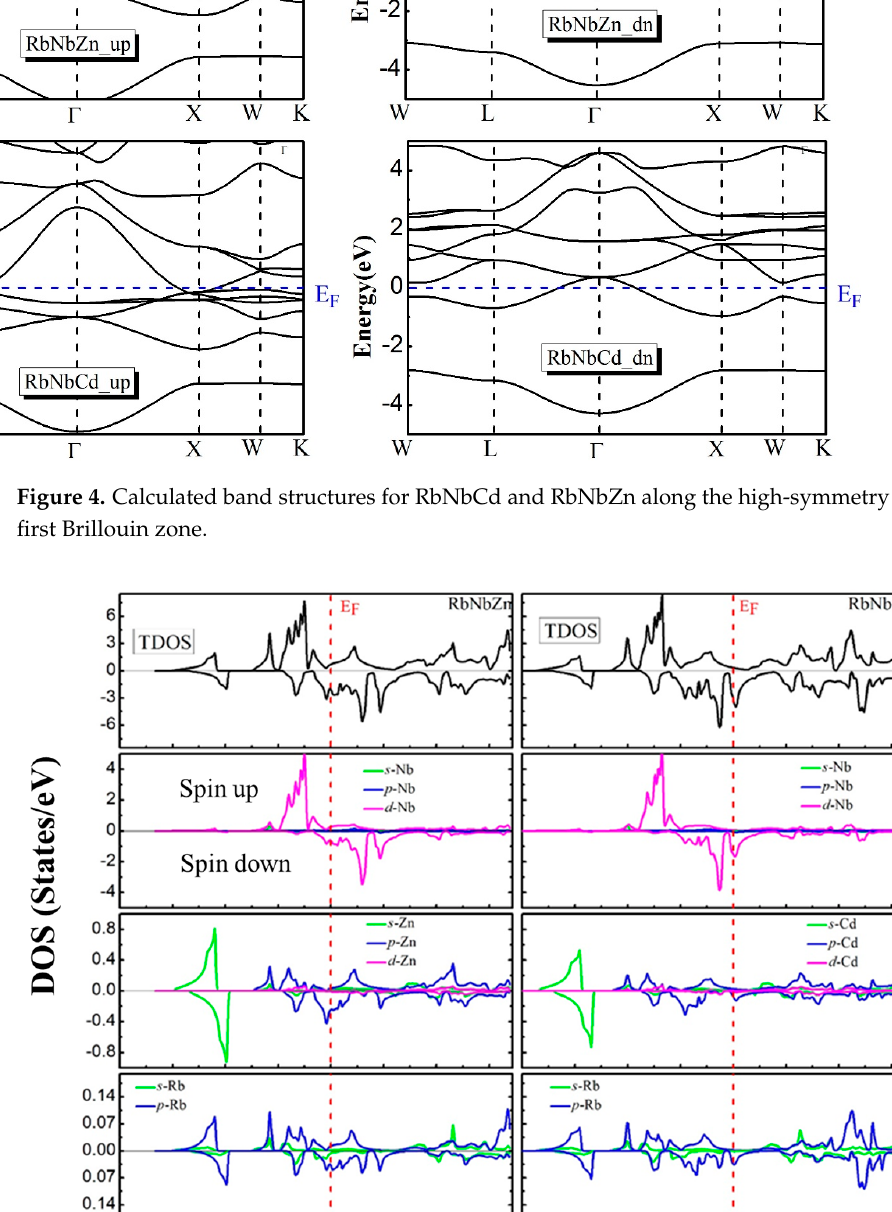
Figure 4. Calculated band structures for RbNbCd and RbNbZn along the high-symmetry axes of the first Brillouin zone.